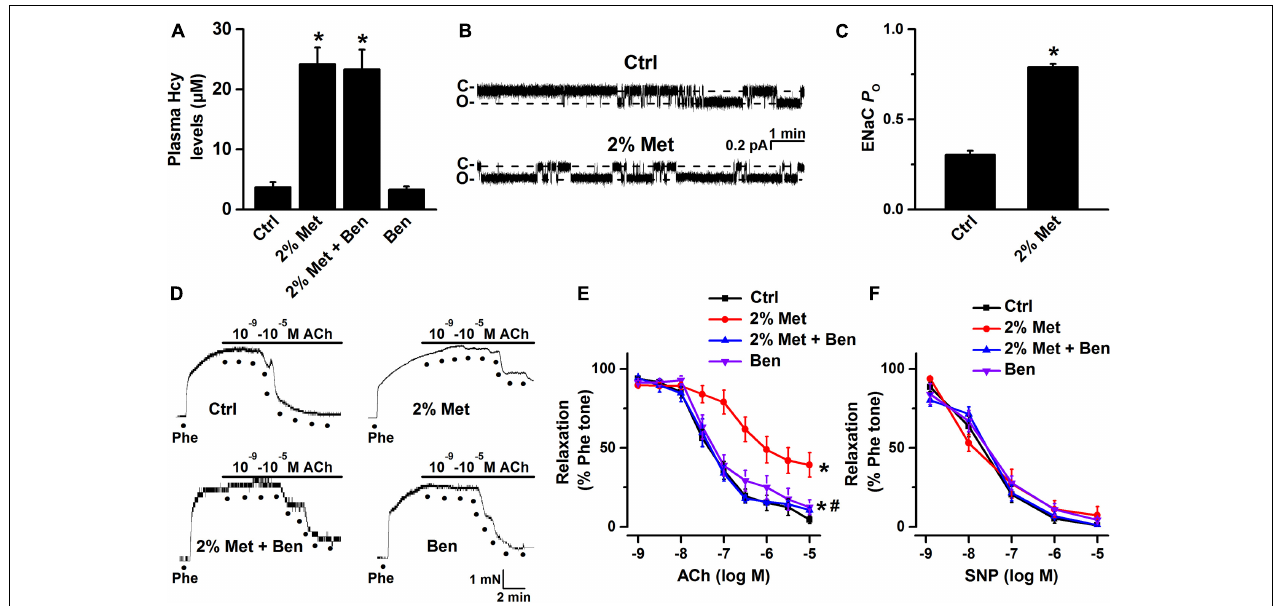
FIGURE 1 | L-methionine-induced HHcy activated aortic endothelial ENaC and impaired EDR was reversed by blockade of ENaC. (A) Mean plasma Hcy levels were measured in control and L-methionine (Met)-treated mice with or without benzamil (Ben) treatment. Data are means ± SEM of six mice. * P < 0.05 vs. ctrl. (B) Representative ENaC single-channel currents were recorded in endothelial cells of the split-open aorta isolated from control (Ctrl) and L-methionine-treated mice. (C) ENaC activity ( P O ) summarized from the experiments as shown in (B) . Data are means ± SEM of six mice. * P < 0.05 vs. ctrl. (D) Representative traces obtained from wire myograph assays and (E) summarized data of acetylcholine (ACh)-induced relaxation of aorta pectoralis from control and L-methionine-treated mice with or without benzamil treatment. The first dot indicates the application of 10 − 9 M ACh to the 1 µ M phenylephrine (Phe) precontracted arterial rings, whereas the following dots indicate ACh concentrations gradually increased from 10 − 8 . 5 to 10 − 5 M. Data are means ± SEM of six mice. * P < 0.05 vs. ctrl; # P < 0.05 vs. 2% Met groups. (F) Summary of artery relaxation induced by different doses of sodium nitroprusside (SNP) concentrations ranged from 10 − 9 to 10 − 5 M in control and L-methionine -treated mice with or without benzamil